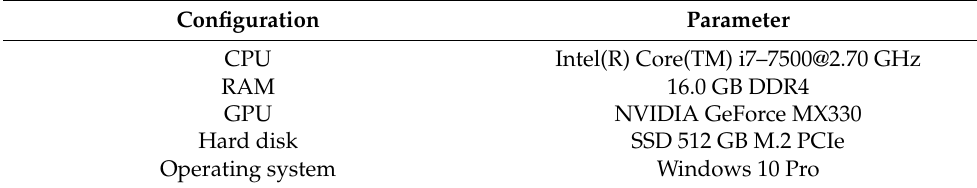
Table 2. Hardware and software environmental configuration used for modelling.